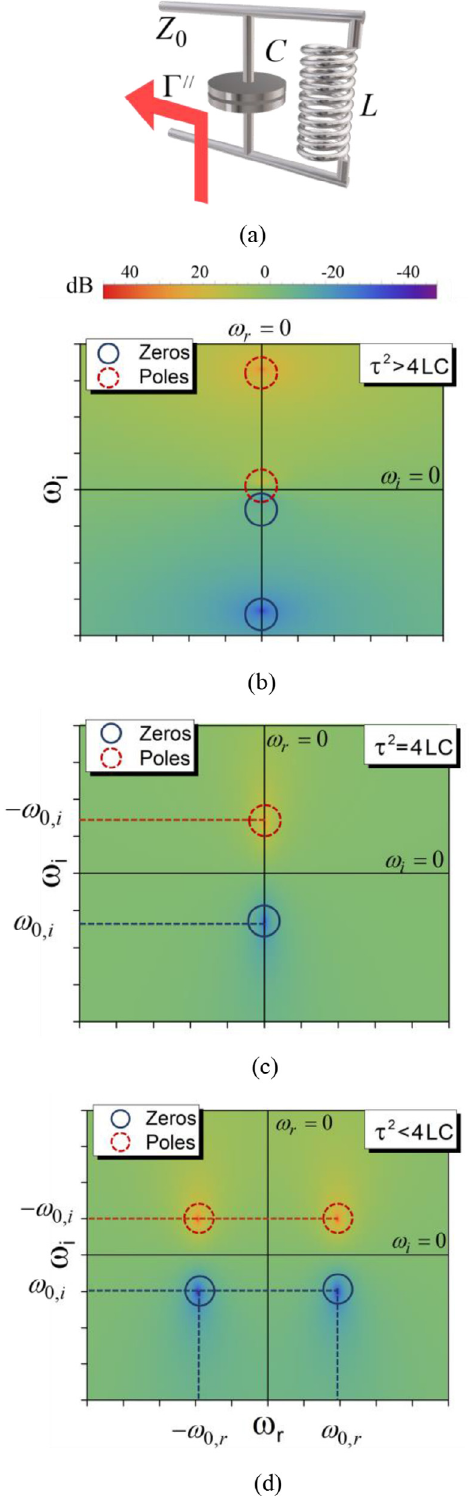
Fig. 3. Quality behaviour of the re fl ection coef fi cient amplitude G in the complex plane showing zeros in lower half-plane and poles in higher half-plane. Respectively zeros are, for a (a) parallel connection of an LC load case study, (b) purely imaginary when t 2 > 4 LC , (c) coincident purely imaginary when t 2 = 4 LC , (d) complex when t 2 < 4 LC